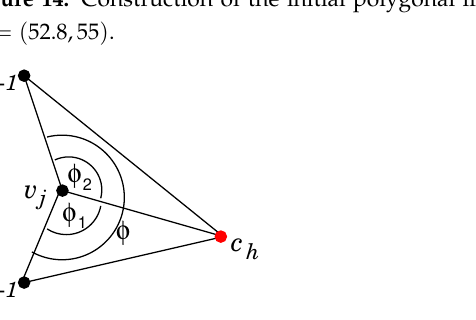
for the example instance “tsp10”, where 1